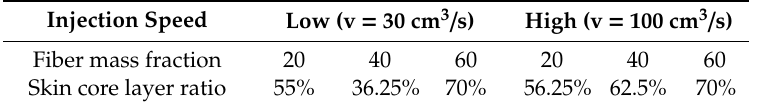
Table 2. Skin core layer ratio for different fiber concentrations and injection speeds of PP-LGF.